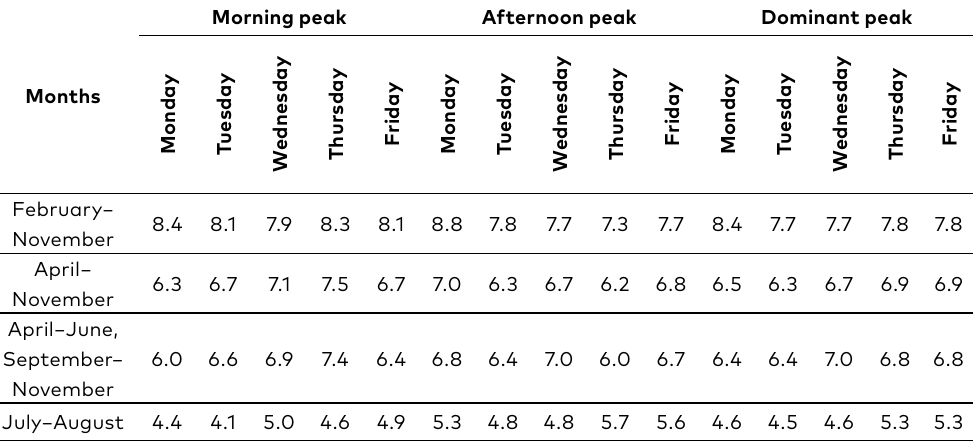
Table 2. Average value of in per cent of the peak